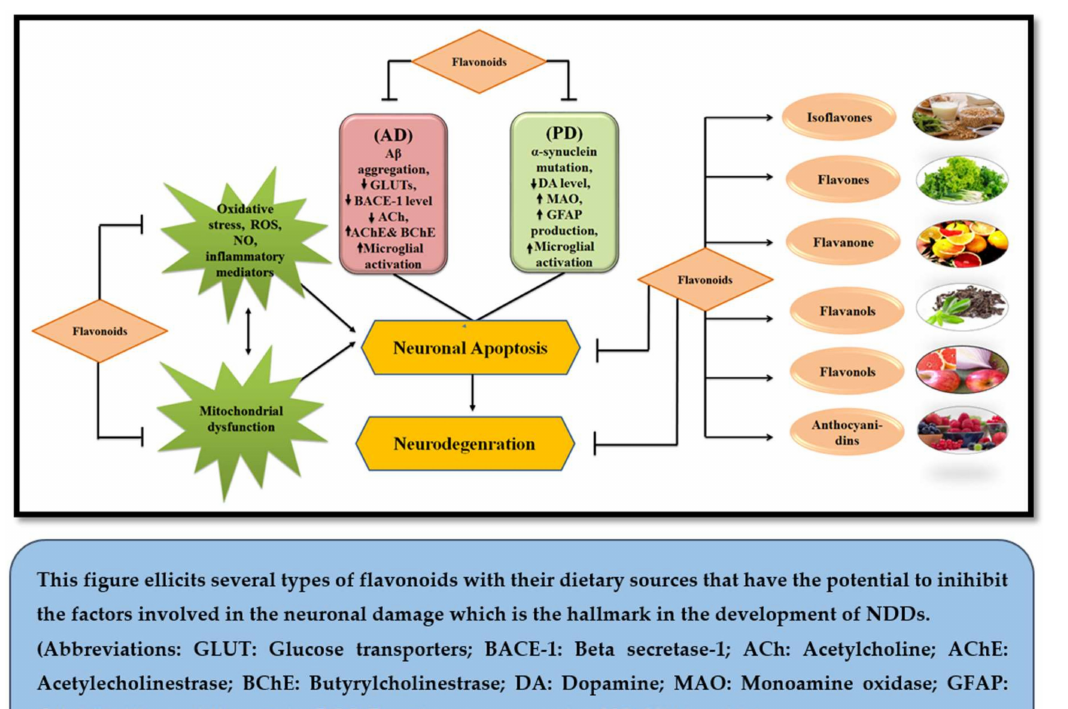
Figure 2. Neuroprotective potential of